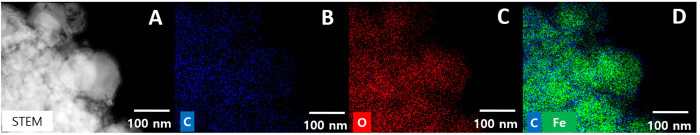
EDX mapping of the Fe3O4@C nanostructures.(A) STEM image, (B) carbon atoms, (C) oxygen atoms, and (D) carbon and iron atoms.